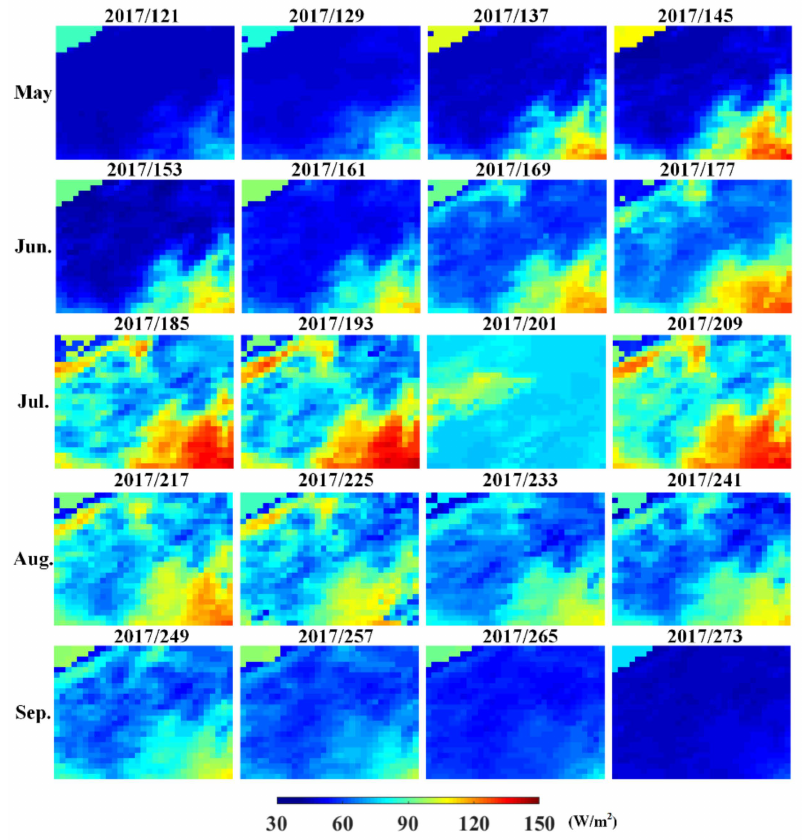
Figure 10. Spatial time series (every 8 days) of MODIS LE product before fusion in the growing season (from May to September